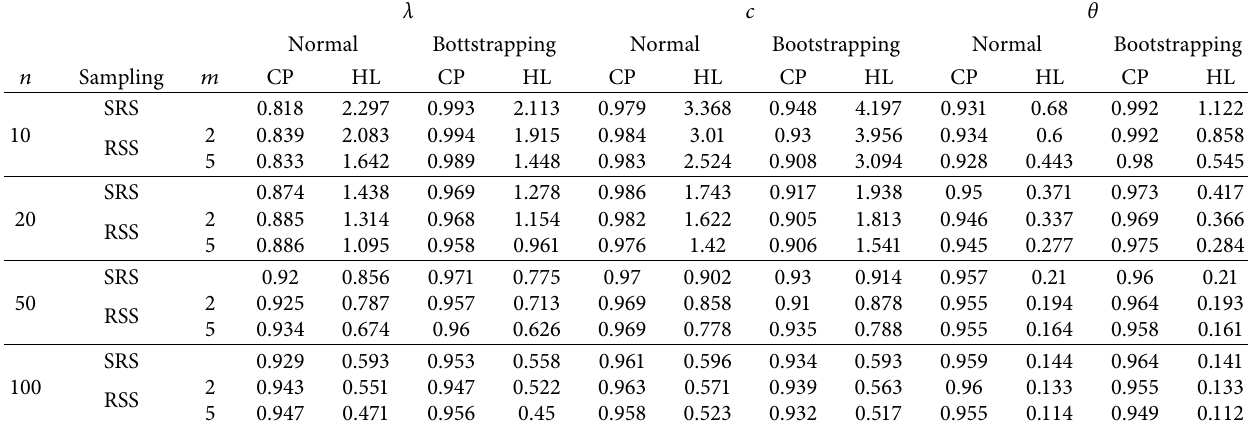
Table 7: Coverage probability (CP) and half length (HL) of the confidence intervals of the parameters using normal approximation and